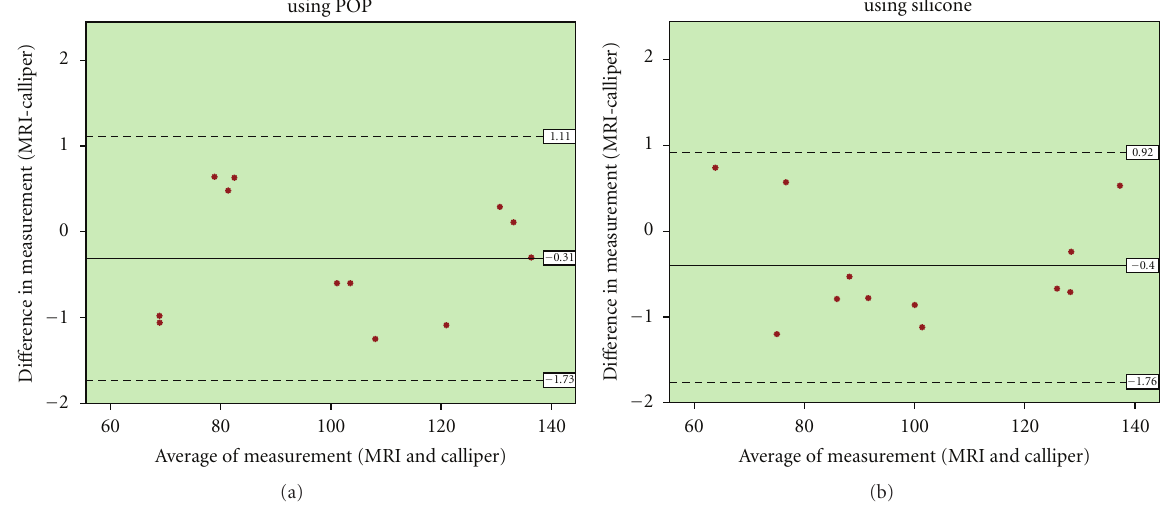
Figure 7: Bland and Altman plot for the diameter measurement comparison of vernier calliper and MRI; (a): POP and (b): silicone.